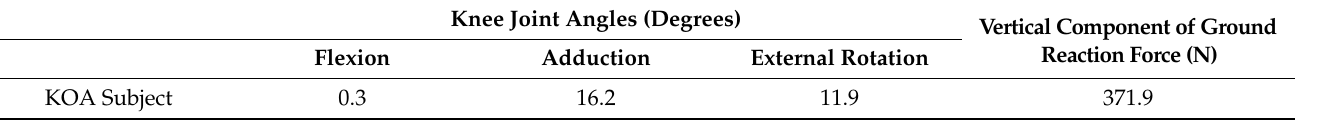
Table 1. Knee joint angles and vertical component of ground reaction force.